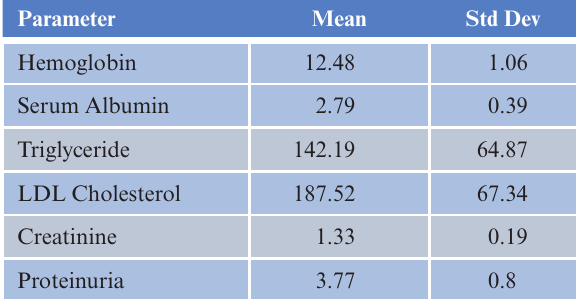
Table 1: Biochemical parameters.